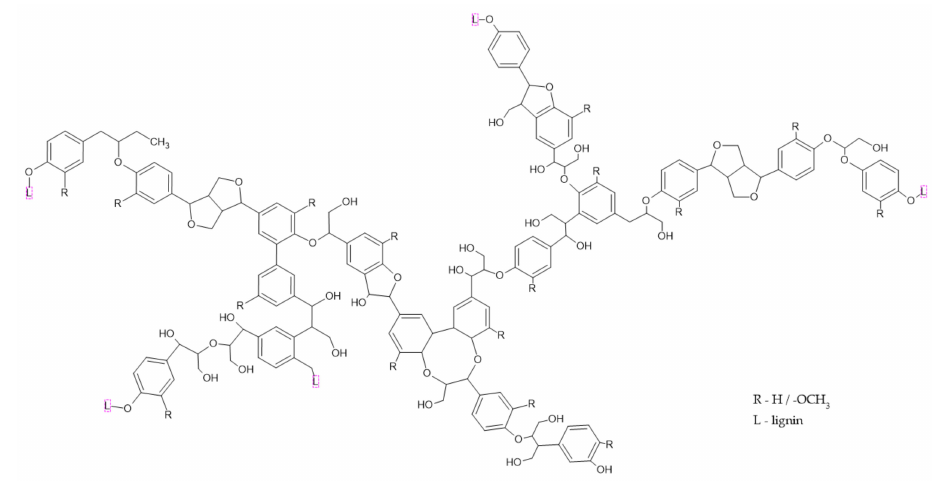
Figure 6. The typical structural model of lignin